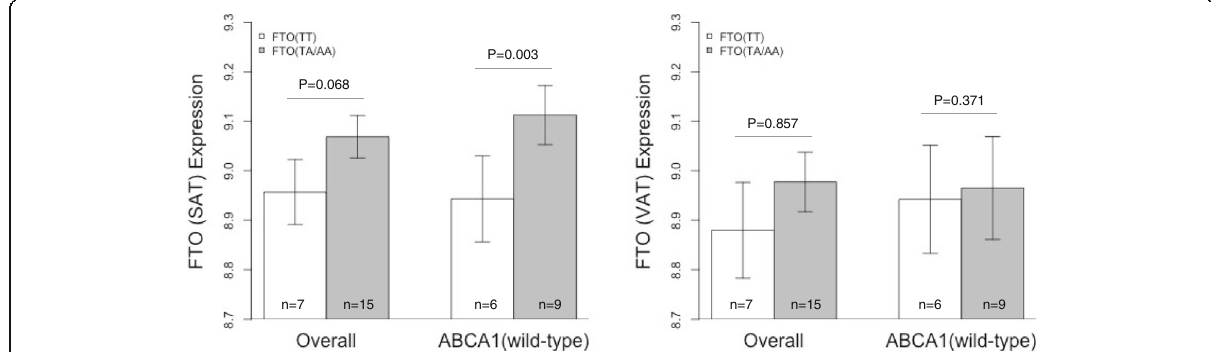
Fig. 3 FTO mRNA expression levels in subcutaneous (SAT) and visceral adipose tissue (VAT) biopsies, in all tested biopsies ( n =22), and in individuals not bearing the ABCA1 rs9282541 risk variant (wild-type, n =15). P -values were obtained adjusting by age and